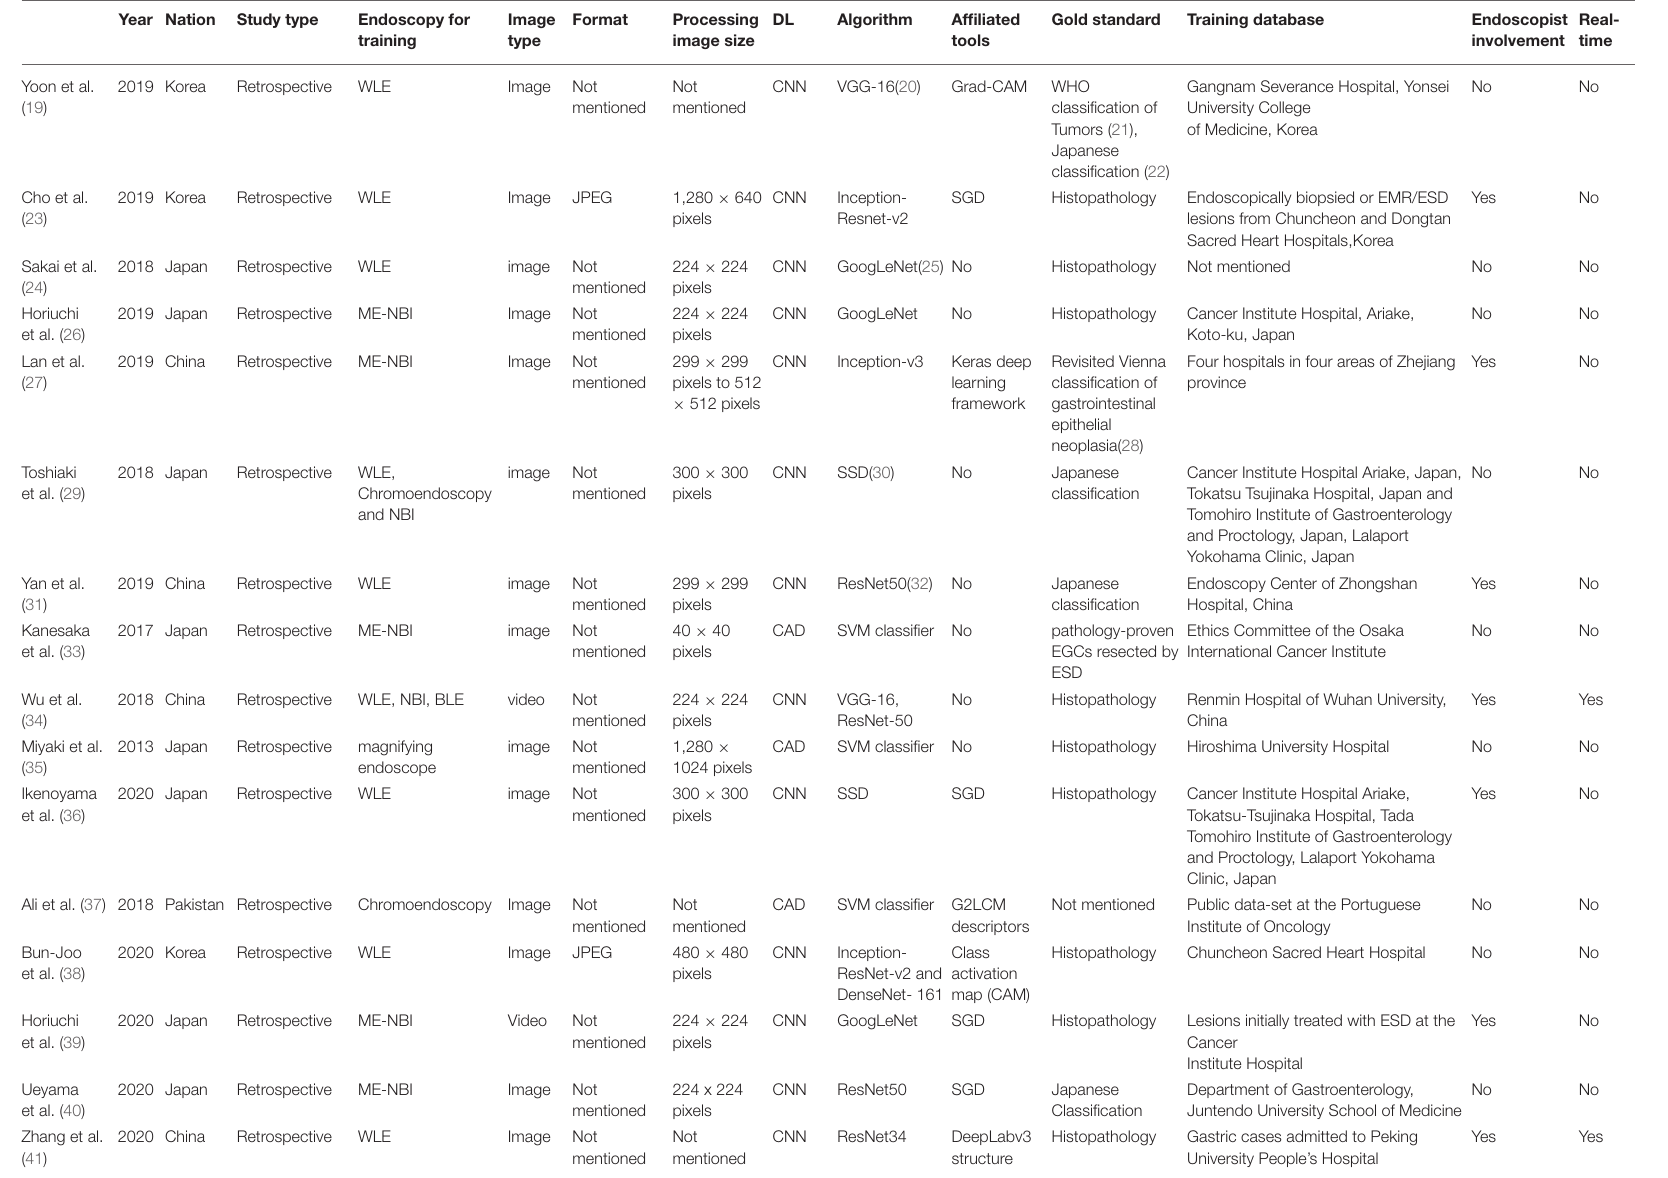
TABLE 1 | Basic characteristic of the included